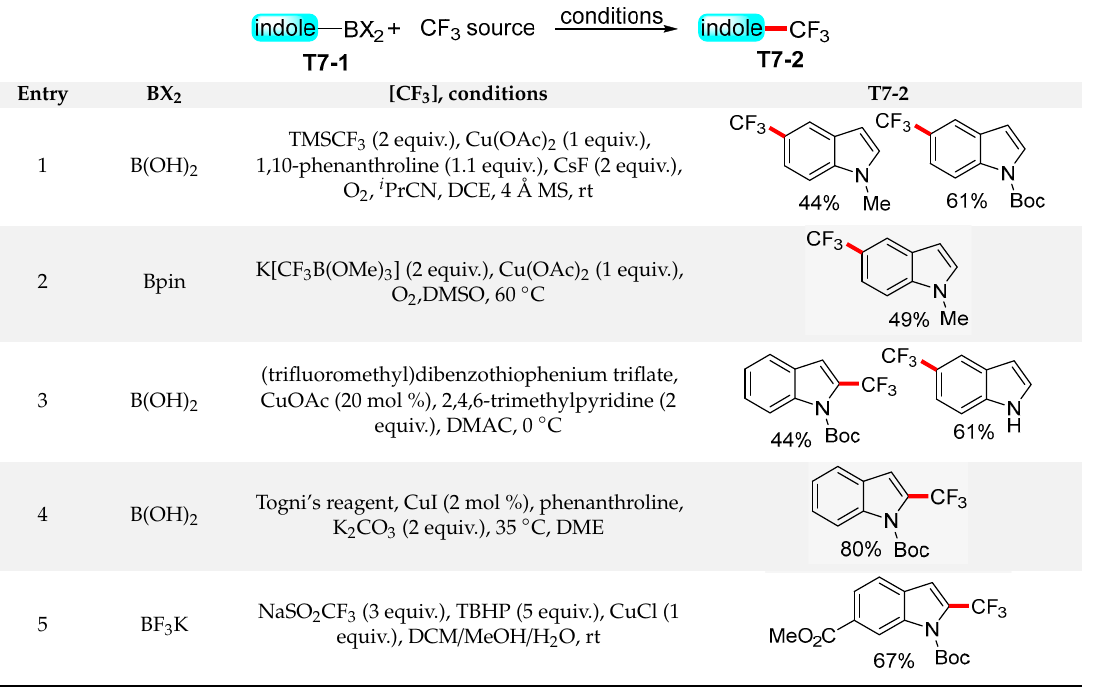
Table 7. Examples of indole trifluoromethylation.